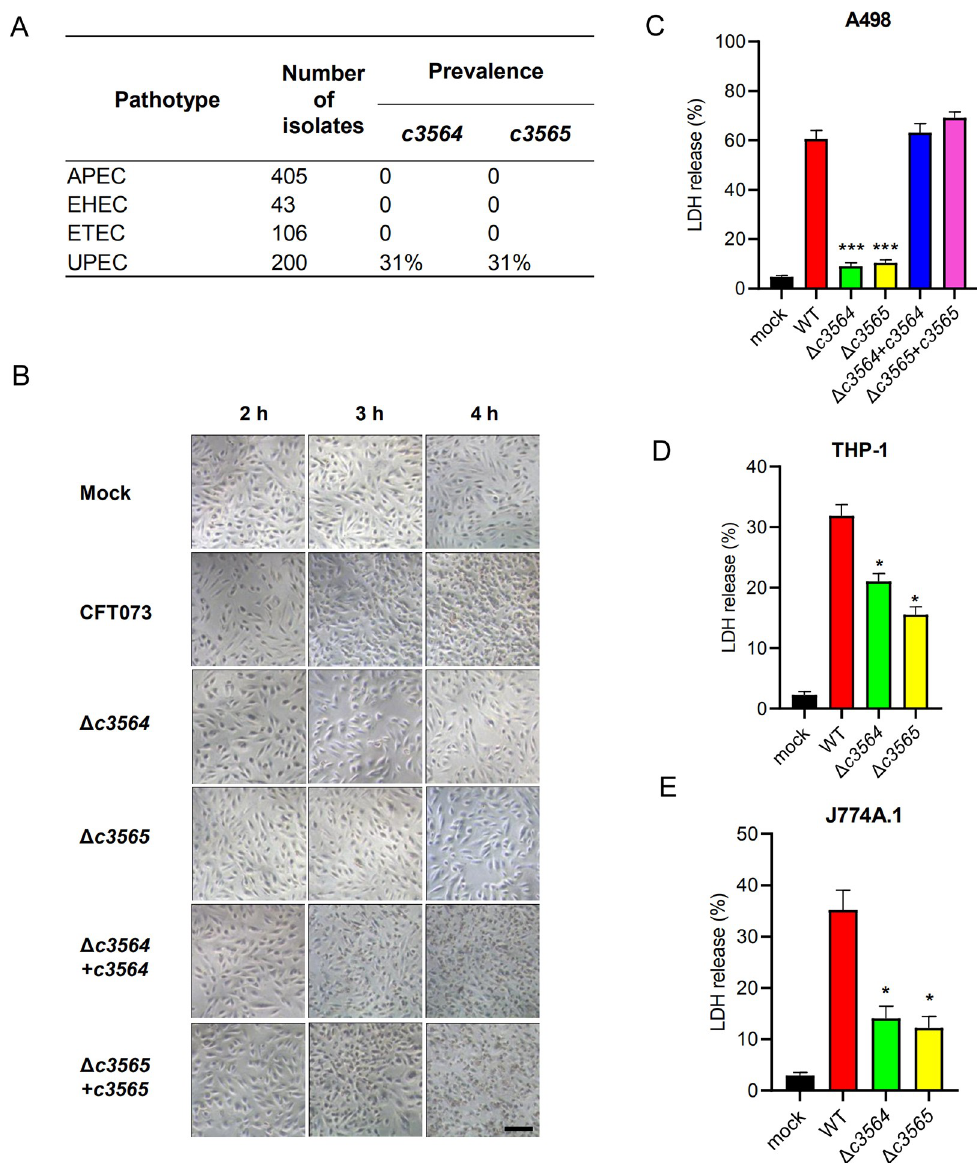
Fig 2. c3564 and c3565 promote host cell death during infection in cell culture models. (A) Prevalence of c3564 and c3565 in various E . coli pathotypes. A duplex PCR method was used to detect the presence of the c3564 and c3565 genes in a laboratory collection of E . coli isolates. APEC, avian pathogenic E . coli ; EHEC, enterohemorrhagic E . coli ; ETEC, enterotoxigenic E . coli ; UPEC, uropathogenic E . coli . (B) c3564 and c3565 affected the morphology of kidney epithelial cells. A498 kidney epithelial cells were infected with CFT073 and its derivatives for the indicated amounts of time and then subjected to phase-contrast microscopy (magnification, 20 × ). All images are representative of three independent experiments. Scale bar, 50 μ m. ( C), (D), and (E) Cytotoxicity assays on different cell types. A498 kidney epithelial cells (C), THP-1 human macrophages (D), and J774A.1 murine macrophage cells (E) were infected with various bacterial strains at a multiplicity of infection (MOI) of 10 for ~2.5 h, and the cell culture supernatants were then subjected to LDH release measurement. Cytotoxicity (%) was determined by comparing the LDH in culture supernatants to the total cellular LDH (the amount of LDH released upon cell lysis with 0.1% Triton X-100) according to the formula [(experimental − target spontaneous)/(target maximum − target spontaneous)] × 100. The data are the mean ± SD of three replicates from three independent experiments. � , P < 0.05; ��� , P < 0.001 by one-way ANOVA followed by Dunnett’s multiple comparisons test against wild-type